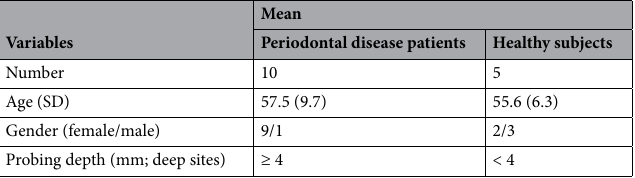
Table 1. Summary of volunteers and